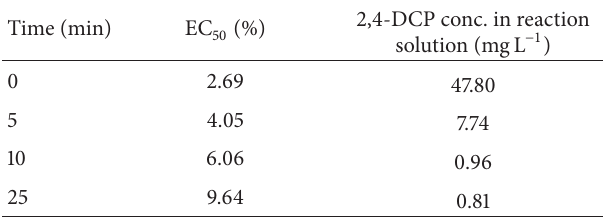
Table 3: Determined values of EC 50 , the effective concentration of the sample that causes 50% decrease in the light output of the Vibrio fischeri organism under 15